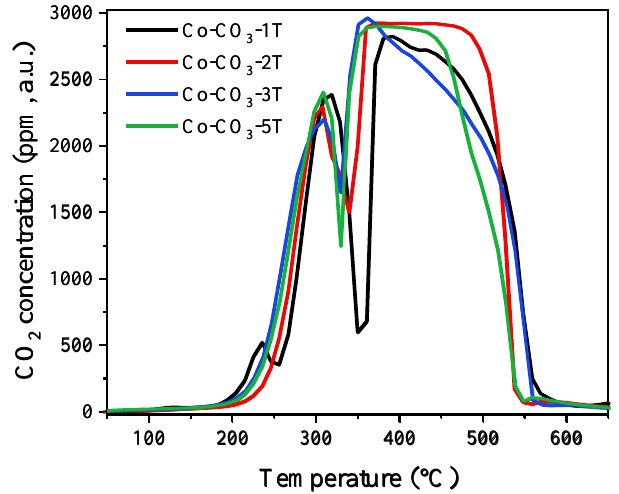
Figure 6. The evolution of CO 2 concentration during the CO-TPR tests of the catalysts.